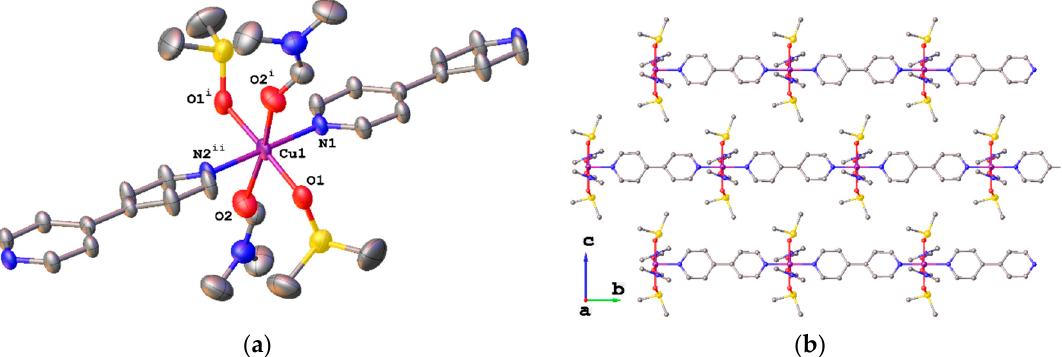
Figure 4. ( a ) Coordination environment of the copper center in compound 6 (thermal ellipsoids drawn at the 50% probability level). ( b ) 1D chains along the plane cb . Color code: Cu, purple; O, red; N, blue; C, grey; S, yellow. Anions and H atoms omitted for clarity. Symmetry operations: i = 3/2 − x , + y , 1 − z ; ii = 3/2 − x , − 1 + y , 1 − z .